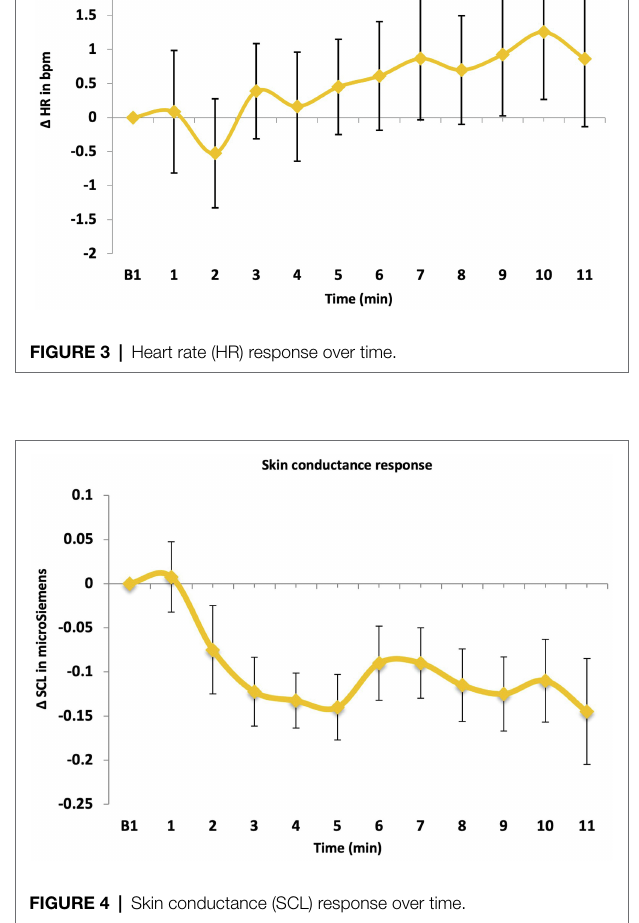
FIGURE 6 | HR variability over